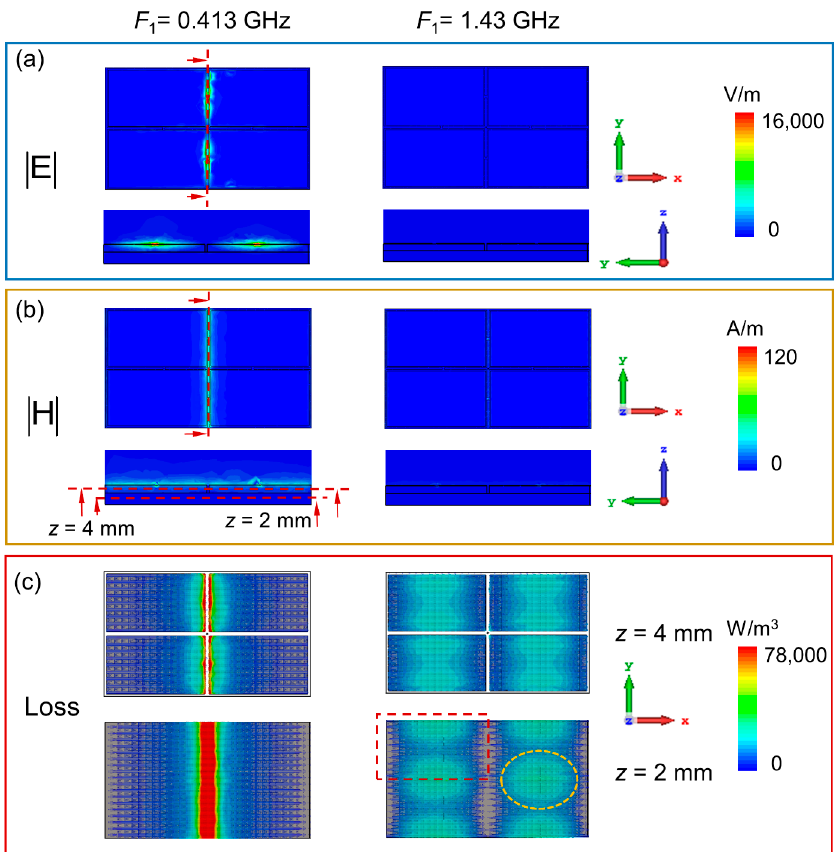
Figure 4. Distributions of ( a ) electric field, ( b ) magnetic field, and ( c ) power loss under the y -polarization normal incidence at 0.413 GHz and 1.43 GHz. The cross-section is cut along the red dotted line.